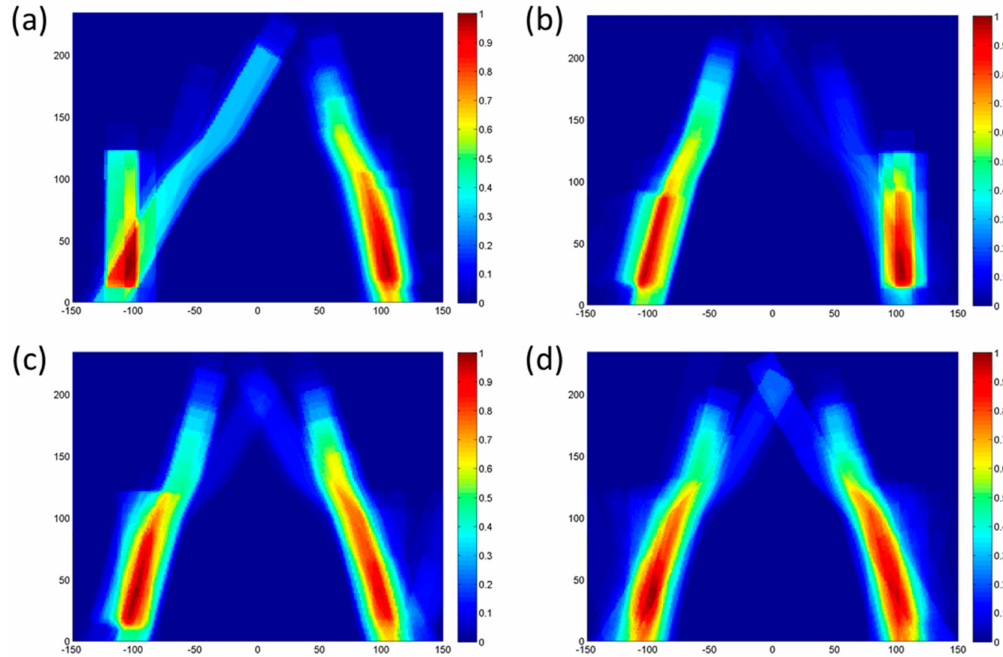
Figure 16. Top view of the generated heat-maps for the results obtained along the Pareto front (red: high patch concentration, blue: low patch concentration): ( a ) basic setup (B-Opt 1), ( b ) higher mutation rate (B-Opt 2), ( c ) change of replacement type (B-Opt 3), ( d ) niching pressure (B-Opt